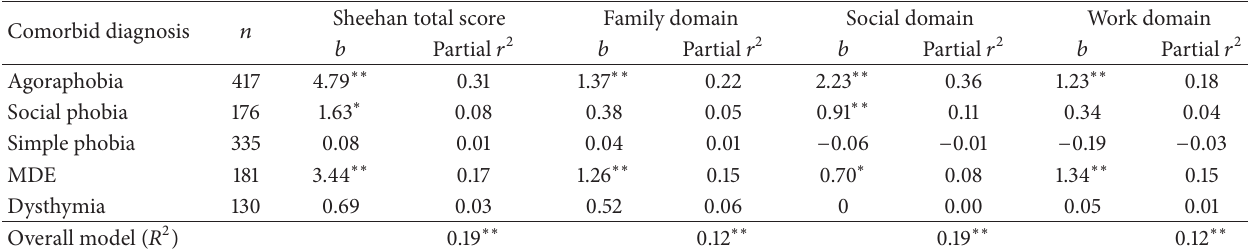
Table 2: Linear regression of comorbid conditions and disability.